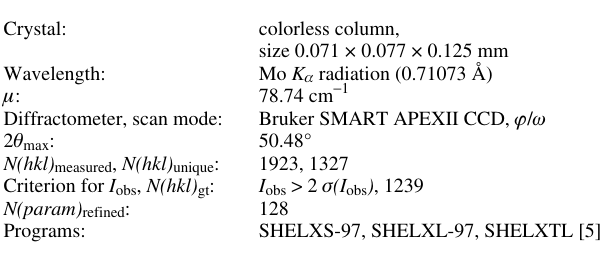
Table 1. Data collection and